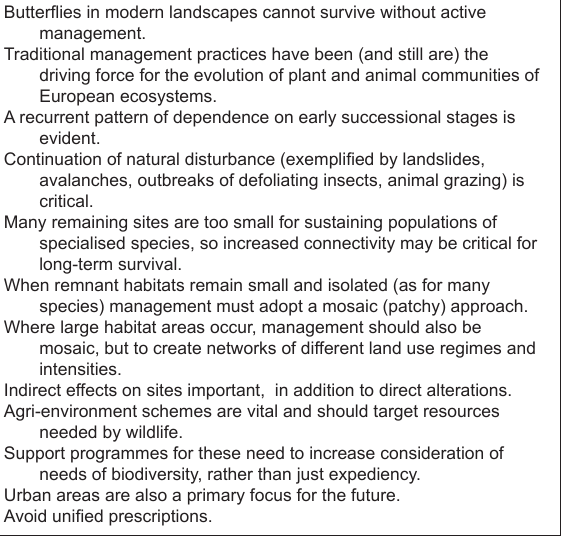
Table 2. Factors that may help guide conservation of butterflies, based on the European fauna (after Settele et al. Butterflies in modern landscapes cannot survive without active management.